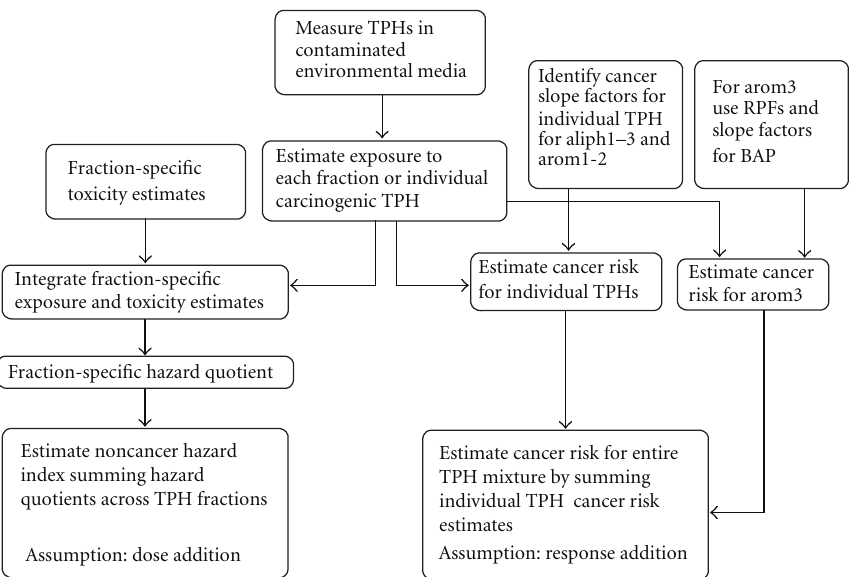
Figure 1: Approach to estimate TPH cancer risks and noncancer Hazard Indices using component and mixture fraction methods. Whole mixture toxicity data are not available for the many, highly variable TPH mixtures of concern that are found at di ff erent sites, and as a result, both MADEP and TPHWG have proposed a fractional and subsequent surrogate/component-based approach for the risk assessment of TPHs. This figure shows that following the measurement of TPHs in either soil or water, both MADEP and TPHWG recommend that exposure estimates be developed for each fraction. Relying on surrogates for each fraction, Figure 1 shows that whole mixture risk assessments can be done using data directly on the mixture of concern, on a su ffi ciently similar mixture, on a mixture’s fractions, or on a subset of its